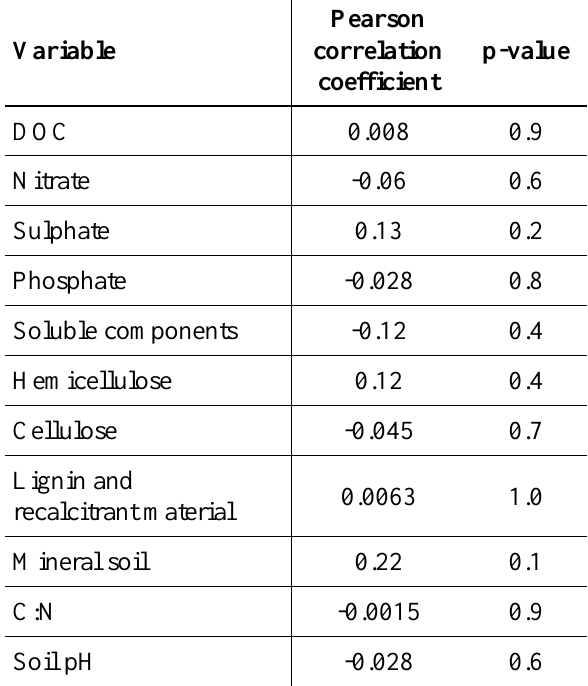
Table 4. Correlations of carbon dioxide (CO with biochemical parameters across the deep cores from all sites.